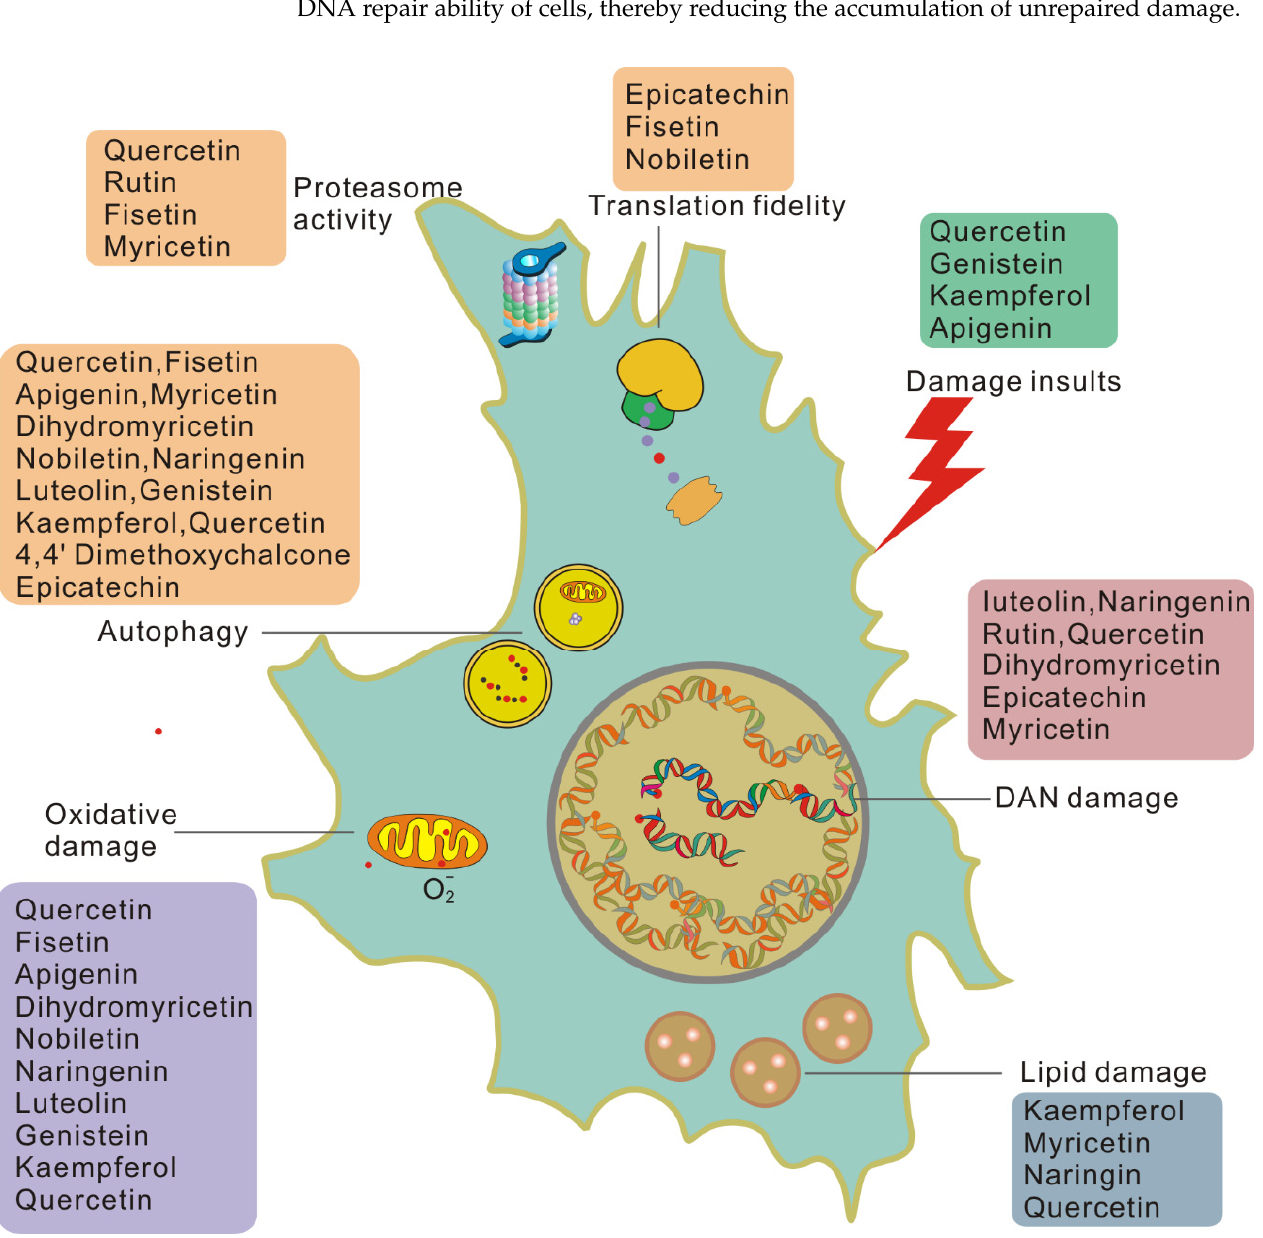
Figure 3. Flavonoids work on each type of damage-dependent trigger of cellular senescence. Cells induced to senesce by damaging insults exhibit higher basal levels of damage than healthy cells and generate damage at a higher rate.